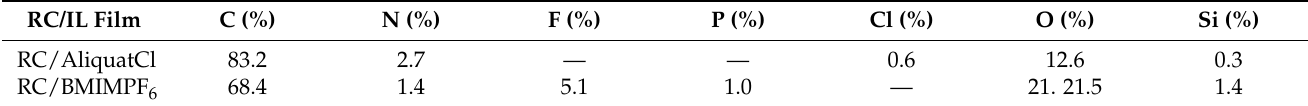
Table 1. Concentration atomic percentages determined at 45 ◦ take-off angle for the different elements observed on the surfaces of the RC/AliquatCl and the RC/BMIMPF 6 films. RC/IL Film